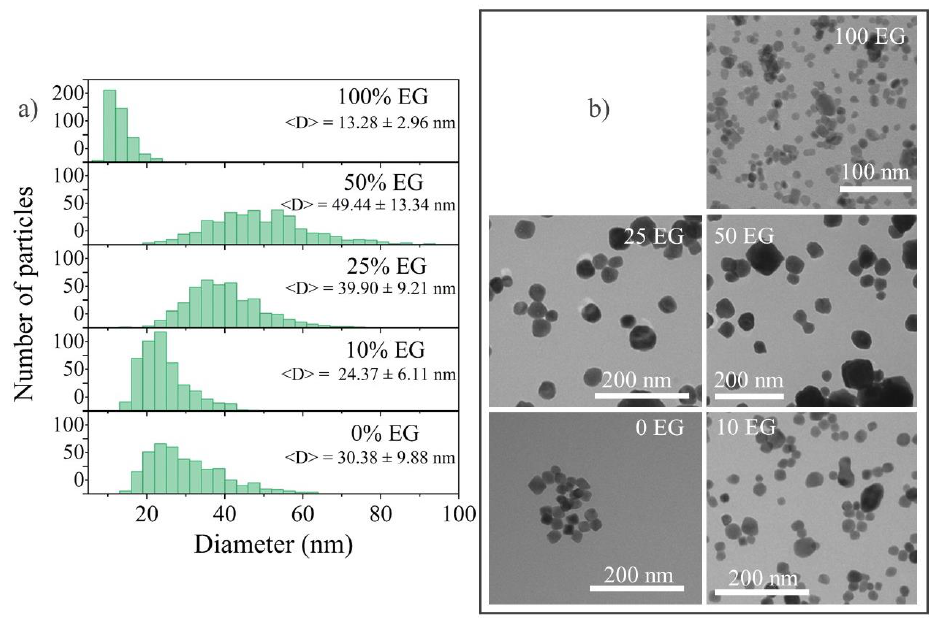
Figure 9. ( a ) Particle size distribution and <D> with the mean size ± standard deviation; ( b ) TEM images of 25Tb ST with different contents of EG 0, 10, 25, and 50%.